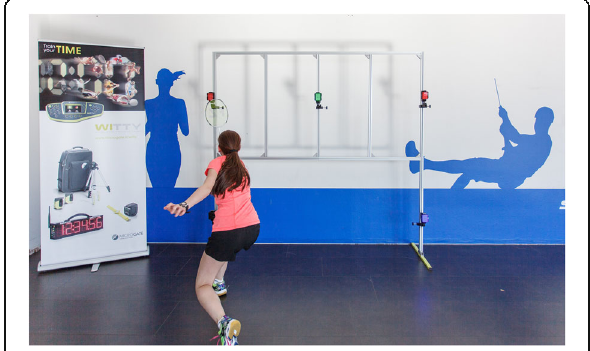
Fig. 3 A badminton player practicing reaction task using the Microgate Witty SEM system (Microgate, Bolzano, Italy). The Microgate Witty SEM shown here consist of a framework holding three LED lights that illuminate green in a random order. In this set-up, the player has to respond quickly and move the racquet in front of the LED that turns